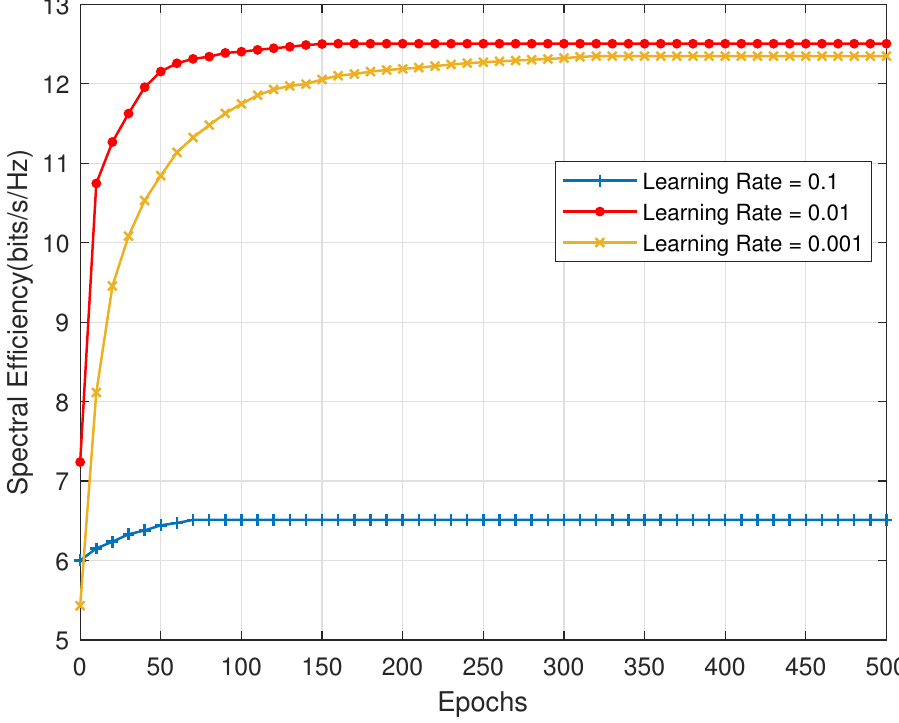
Figure 4. Spectral efficiency performance versus epochs of the proposed scheme under various learning rates in geometric mmWave channel with N t = 64, SNR = 20